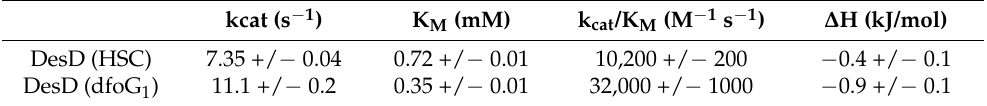
Table 1. Reported kinetic constants for DesD with the limiting substrate identity in